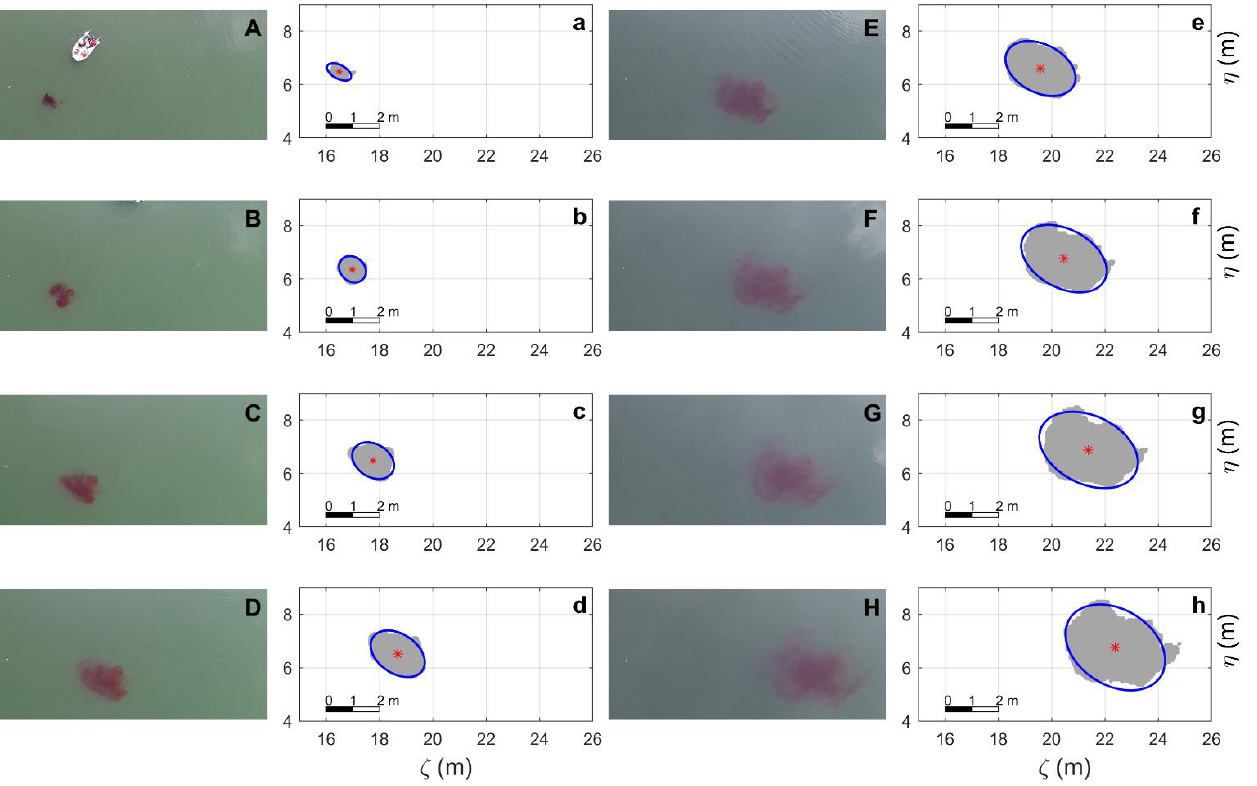
Figure 4. Dye patch extent mapping where the spatial and temporal variation is shown. The images ( A – H ) show the dye patch dispersing over time, whereas the evolution of the corresponding ellipses after processing is shown in ( a – h ). The optimal ellipses are shown in blue with the geometrical center marked with a red asterisk.